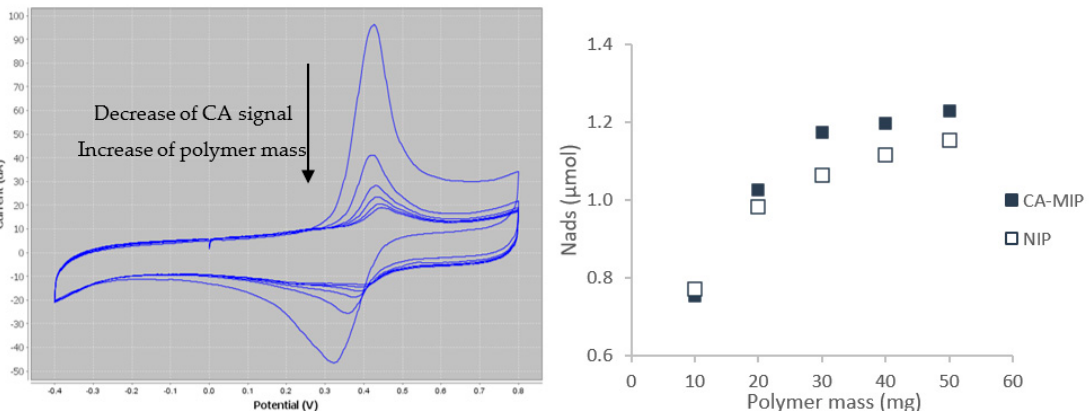
Figure 4. Left: CV for caffeic acid (CA) remaining in the medium after adding different quantities of CA-MIP (0, 10, 20, 30, 40, and 50 mg). Scan rate: 50 mV/s; the arrow shows the reduction of I pa and the remaining caffeic acid with increasing the content of imprinting polymer CA-MIP. Right: effect of the polymer mass on the amount of adsorbed caffeic acid in a PBS 0.05 M/EtOH (90/10, v / v ) solution containing 1.11 mM of caffeic acid. The error bar is 0.15% for all samples.